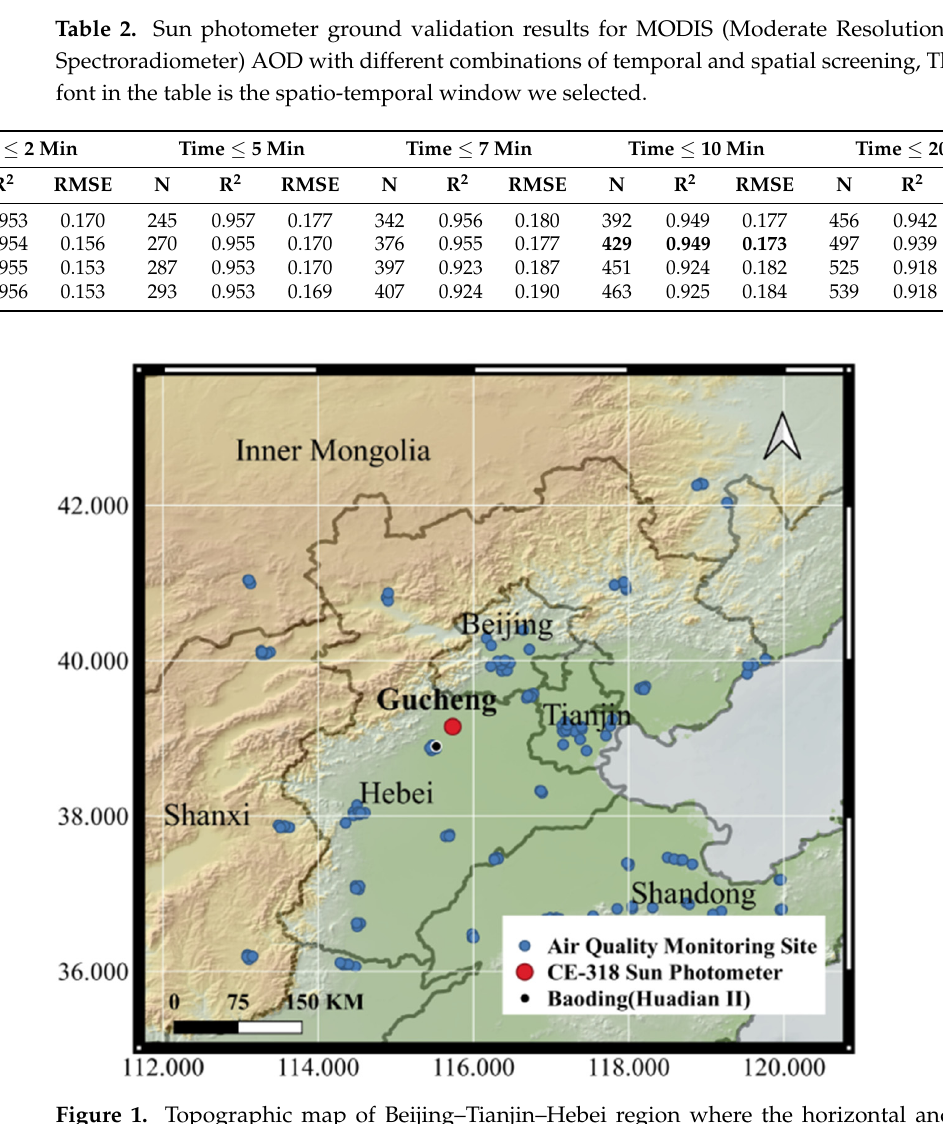
Figure 1. Topographic map of Beijing–Tianjin–Hebei region where the horizontal and vertical coordinates are the latitude and longitude, respectively. The red dot represents the sun photometer station Gucheng, the black dots represent the closest China National Environmental Monitoring Centre (CNEMC) air quality site to Gucheng (Baoding (Huadian II)), the blue dots represent the others CNEMC air quality site, and the solid gray line represents the provincial boundary. Table 1. Sun photometer ground verification results for AHI (Advanced Himawari Imager) AOD with different combinations of time and space screening; the bold font in the table is the spatio- temporal window we selected. Time ≤ 2 Min